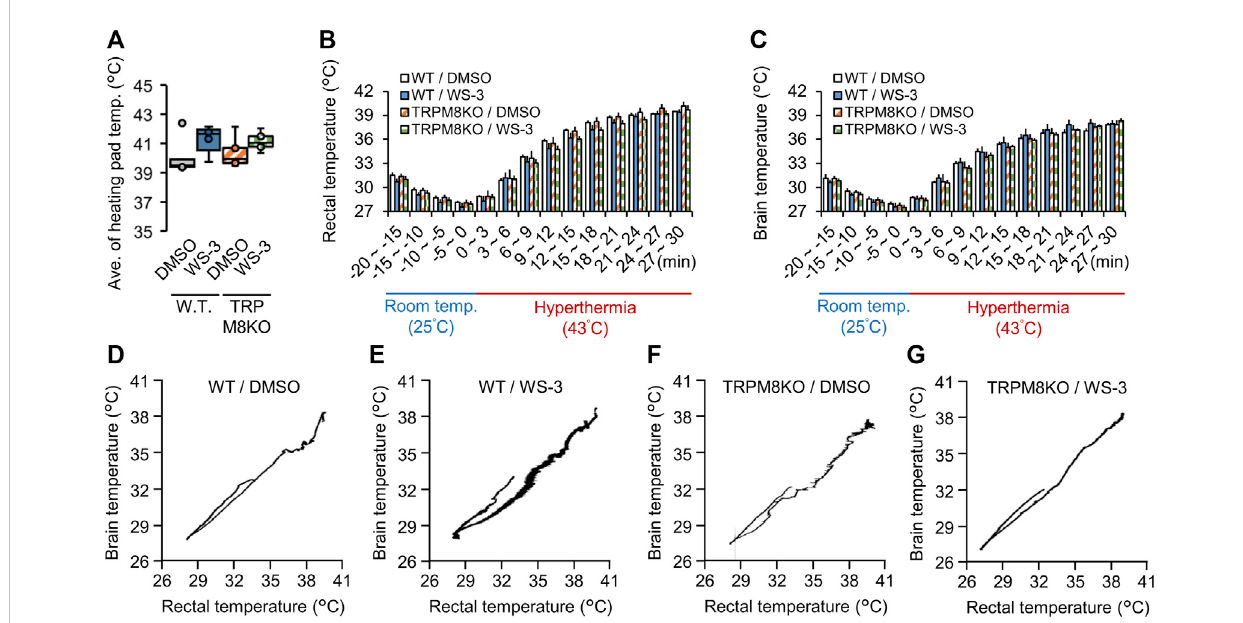
FIGURE 2 Effects of a transient receptor potential melastatin 8 (TRPM8) agonist and TRPM8 de fi ciency on rectal and brain temperatures under the hyperthermic condition. (A) The surface temperature of the heating pad under the hyperthermic condition (43 ° C for 30 min) in wild-type (WT) mouse/ dimethyl sulfoxide (DMSO)(white: n = 5) and WT/WS-3 (blue: n = 5) groups, and TRPM8 knockout (TRPM8KO) mouse/DMSO (orange oblique line: n = 5) andTRPM8KO/WS-3(greensquares: n =5)groups.Changesof (B) rectaland (C) braintemperatureineachgroupunderroomtemperature(25 ° Cfor 20 min) and hyperthermia (43 ° C for 30 min) conditions. (D – G) Representative rectal and brain temperature trends under room temperature and hyperthermic conditions in each